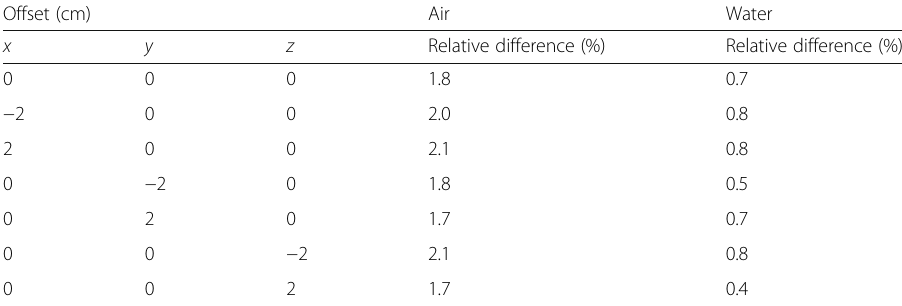
Table 1 Relative differences between estimated and simulated activities in a 9-mL sphere. The projections were simulated using a separate SIMIND simulation and then reconstructed using MCR